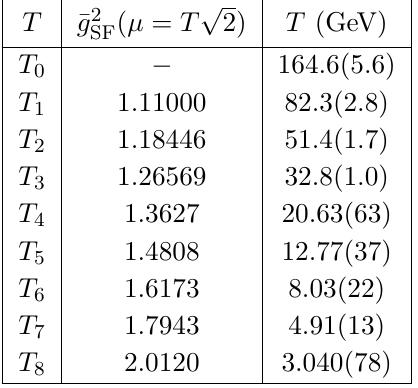
Table 2 . Values of the SF couplings corresponding to the lines of constant physical temperature that we consider.